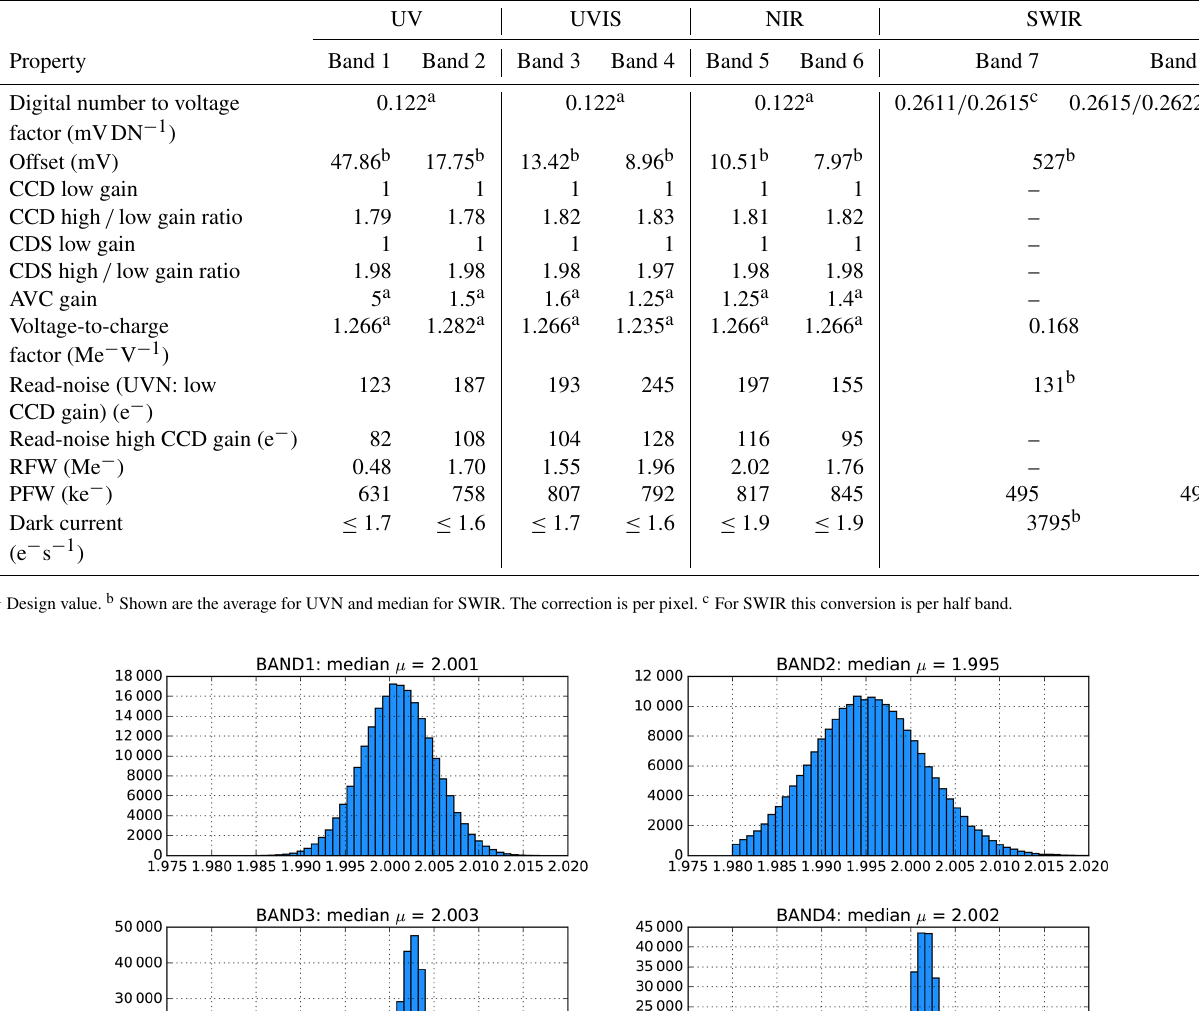
Table 5. The main characteristics of the detectors and front end electronics. Unless stated otherwise, the values for UVN are given for offset = 0 (DAC), even parity, PGA = 1 (code 97), CCD gain low, and CDS gain low. The UVN dark current is based on the maximum column average value. The register full-well value is based on the maximum value at which the non-linearity correction is valid.